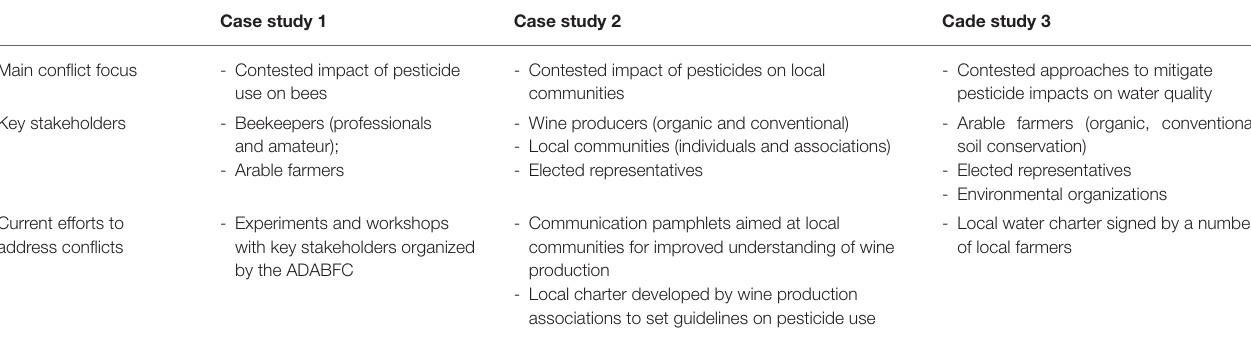
TABLE 1 | General characteristics of the three case